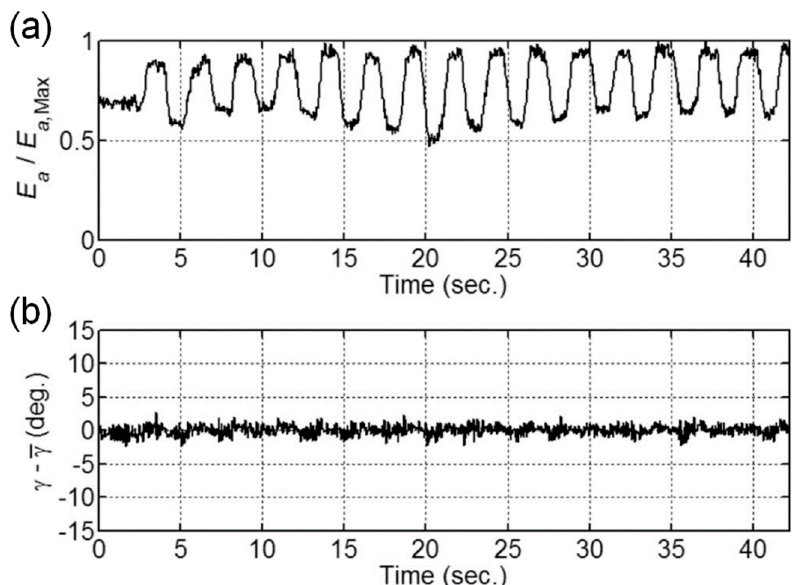
Figure 3. Stability of the extracted polarization direction when using the spinning EO sensor method. ( a ) Time chart of the intentionally modulated magnitude of the terahertz E-field (normalized by the maximum value); ( b ) Time chart of the measured angle of the E-field vector, 𝛾 , relative to its mean value 𝛾̅ . (Reprinted from reference [50] with the permission of AIP Publishing.)